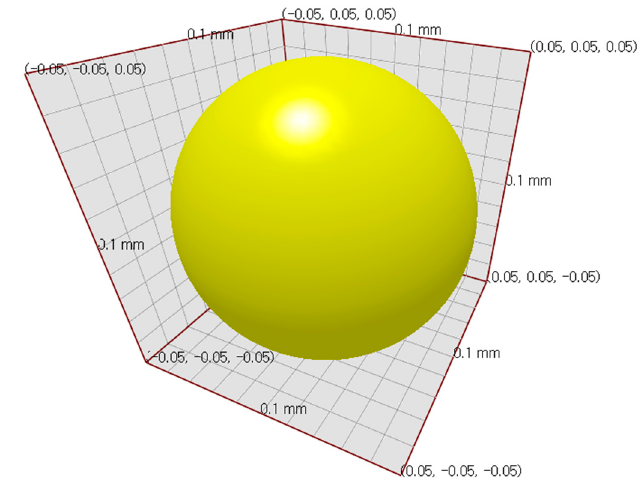
Figure 2. Particle shape used in the DEM simulation.